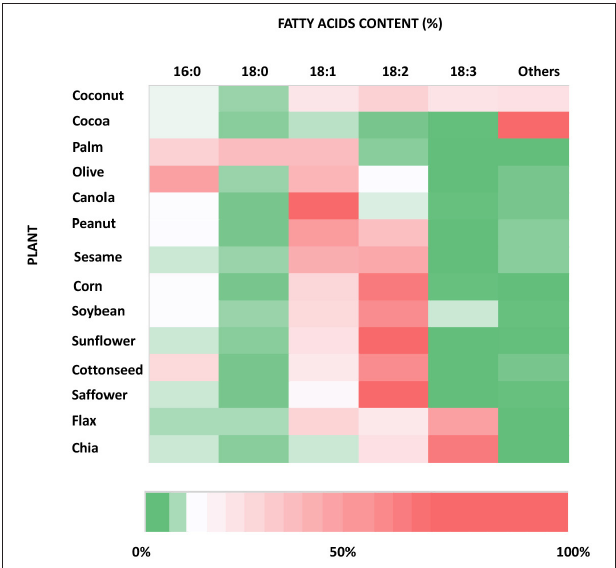
FIGURE 2 | Heat map of the fatty acid content of the most used species of oil producing plants. The information used to produce this graph has been taken from https://lipidlibrary.aocs.org/chemistry/physics/plant-lipid/production-of-